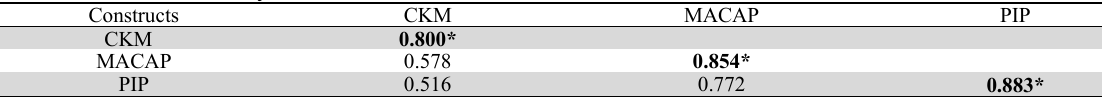
The Discriminant validity of the